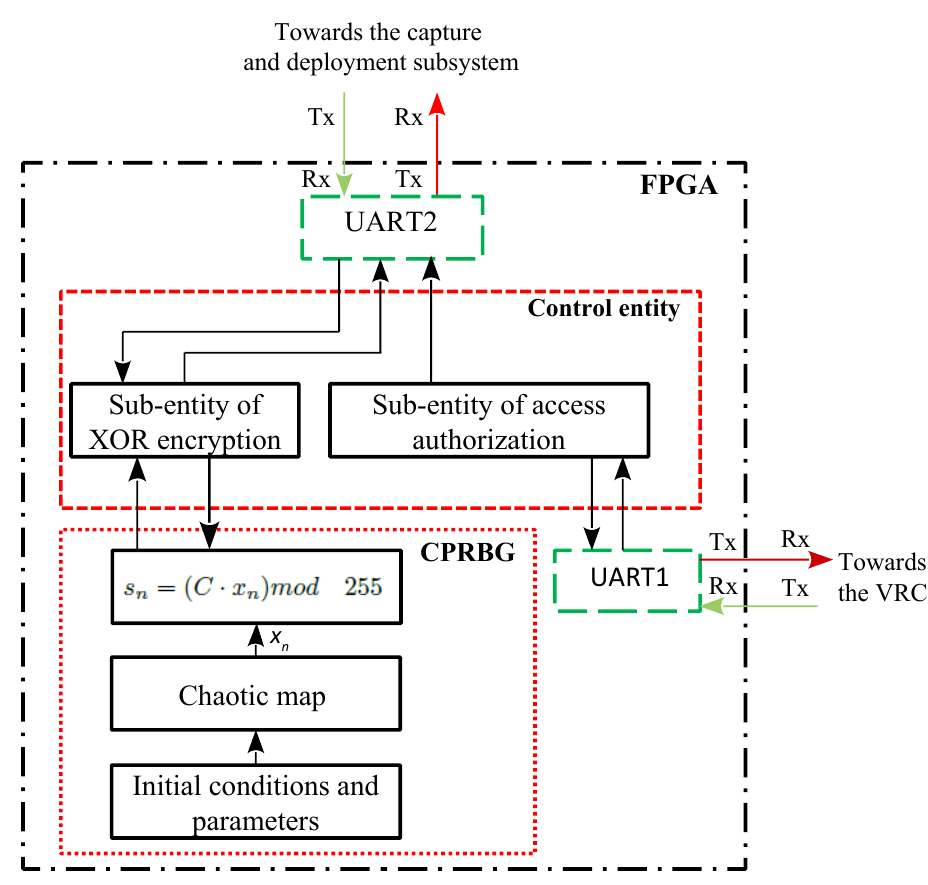
Figure 3. Block diagram of the main control subsystem implemented in FPGA Spartan